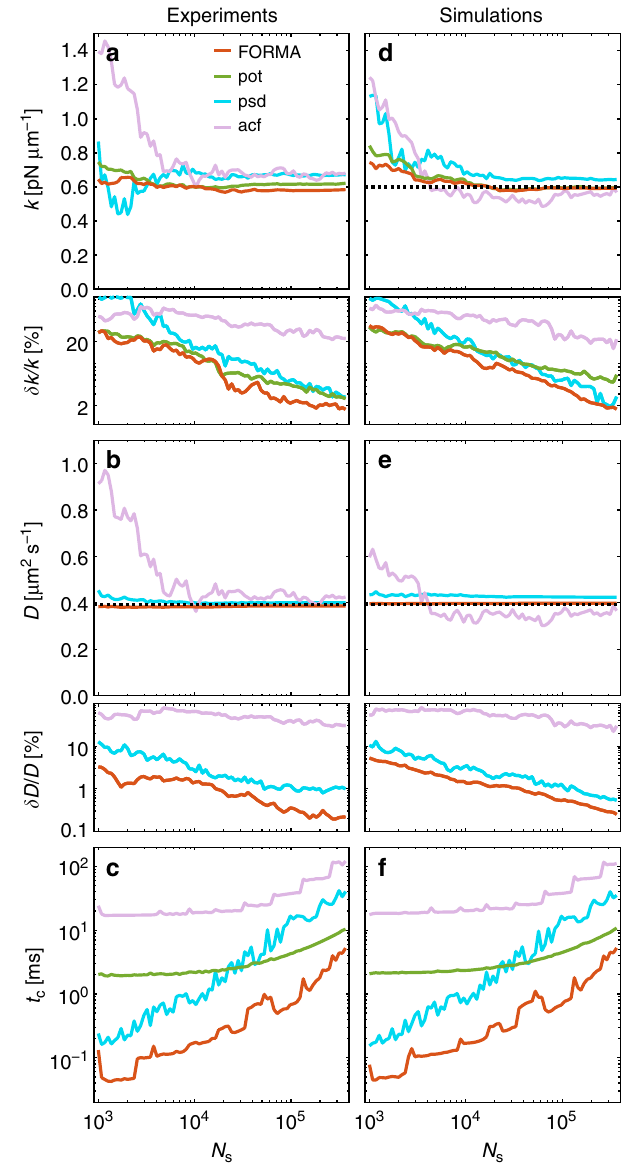
Fig. 2 Better performance of FORMA compared to alternative techniques. Experimentally determined values of a the trap stiffness k and its relative error δ k / k , b the diffusion coef fi cient D and its relative error δ D / D , and c the computational execution time t c as a function of the sample number N s for FORMA (orange lines); and d – f corresponding results from numerical simulations. The comparisons with potential (green lines), PSD (blue lines), and ACF (pink lines) analyses show that FORMA converges faster (i.e. for smaller N s ), is more precise (i.e. smaller relative errors), is more accurate (i.e. it converges to the expected value represented by the black dashed line), and executes faster than the other methods. In all cases, we have acquired/simulated 24 trajectories of the motion of a spherical microparticle with radius R = 0.48 μ m in an aqueous medium of viscosity η